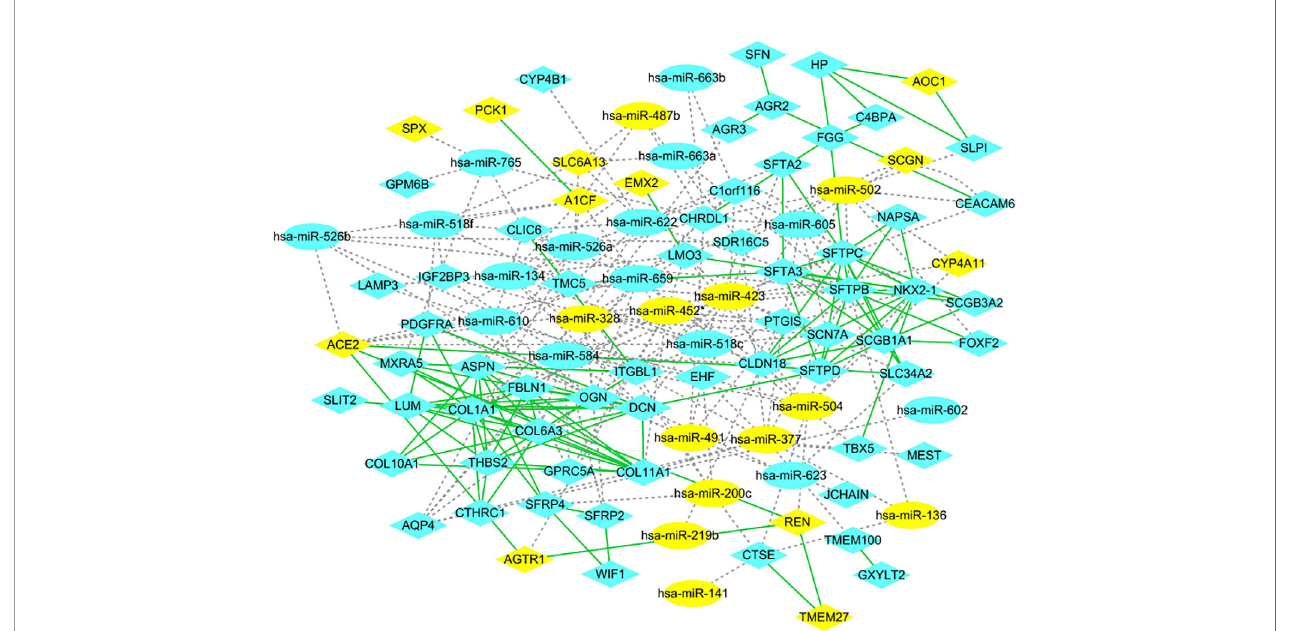
FIGURE 3 | Protein-protein interaction (PPI) network. mRNAs and miRNAs are indicated as ellipsoid and diamond, respectively. The gray dotted line represents the interaction of the miRNA-mRNAs. The green line represents the interaction of the proteins. The yellow indicates high expression, and blue indicates low expression.